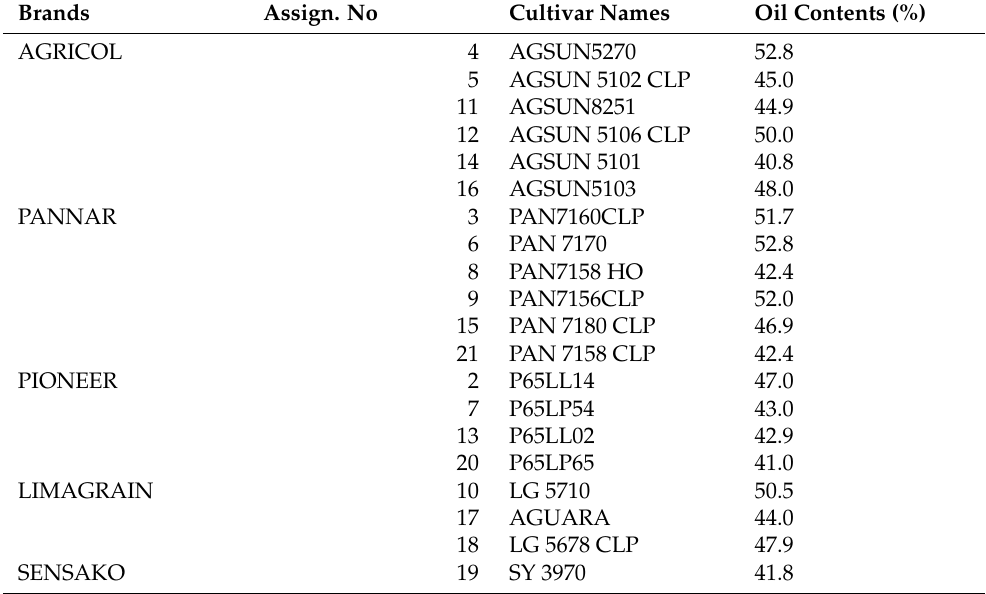
Table 1. Percentage oil composition of sunflower seed